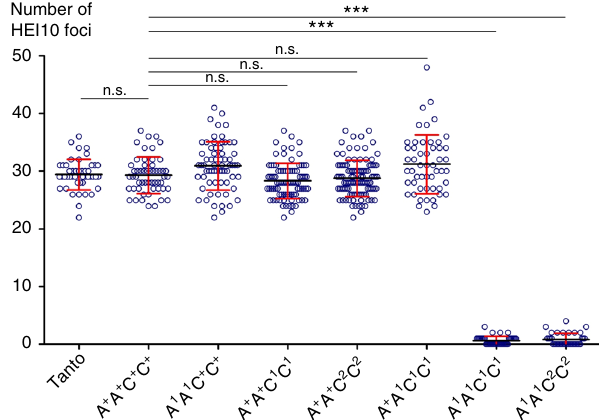
Fig. 3 Robustness of ZMM-dependent crossovers to MSH4 copy number reduction in B. napus euploids. Scatter plot of HEI10 (class I crossover) foci in the different genotypes, as determined by HEI10 immunolocalization. *** indicates highly signi fi cant variations ( p -value < 0.0001) according to Kruskal – Wallis test. Error bars show standard deviation. Means (black bar) are also